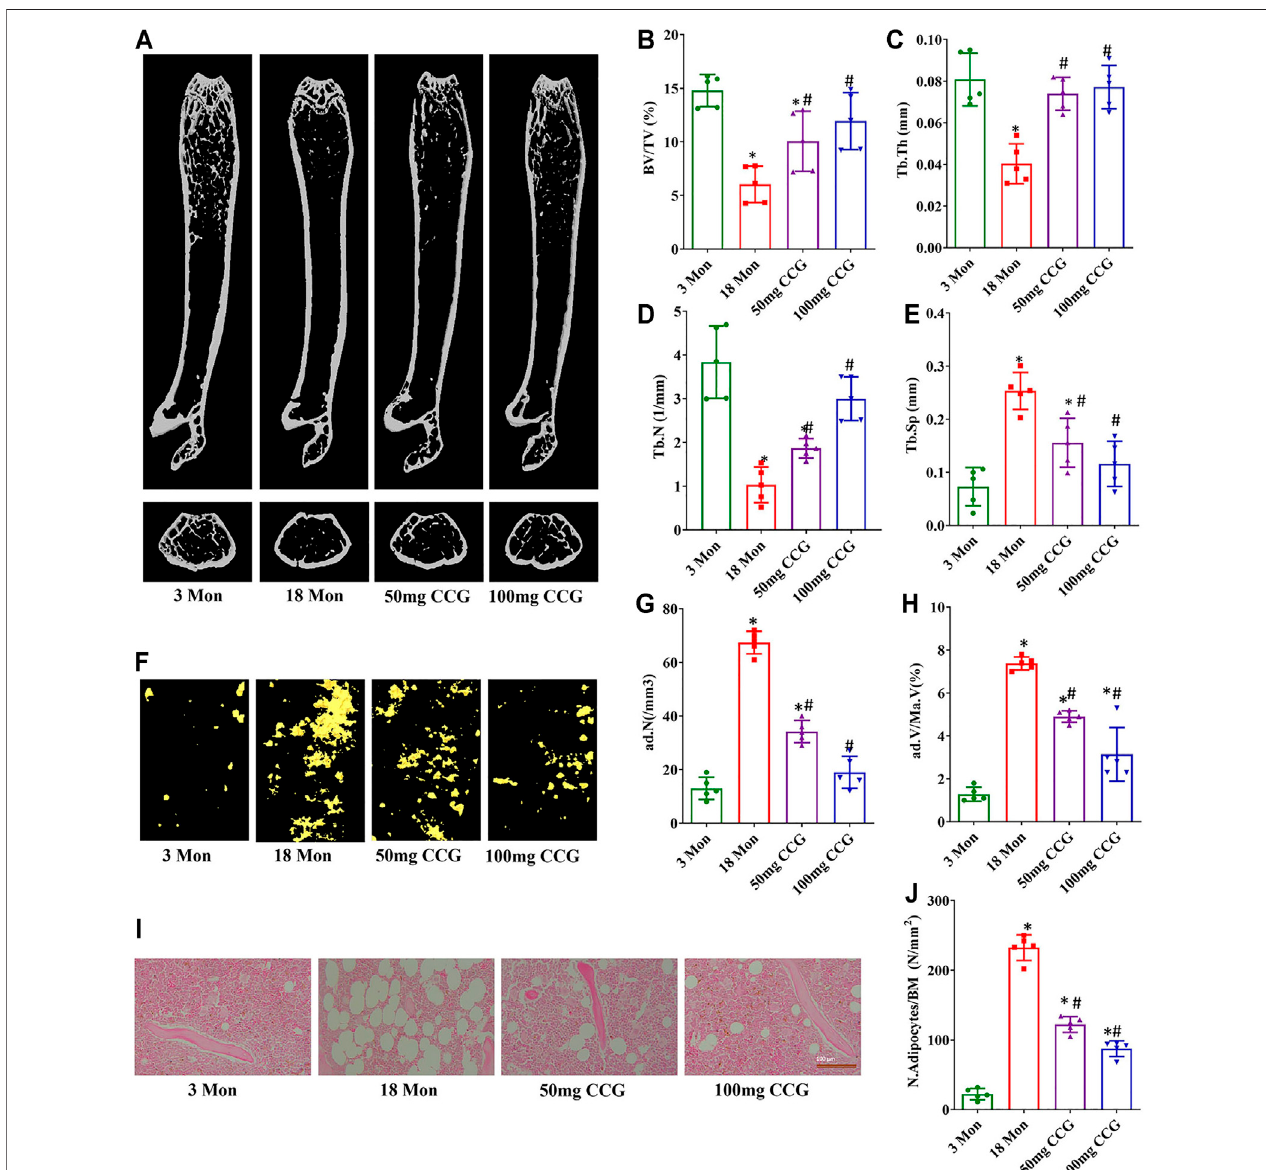
FIGURE 1 | CCG ameliorated bone loss and marrow adiposity of aging mice. (A – E) Representative μ -CT images of femurs from the animals in different groups to acquire the quantitative analysis of trabecular bone. (F – H) Representative μ -CT images of OsO 4 staining of femurs from the animals in different groups to acquire the quantitative analysis of the volume of adipocytes. (I, J) Representative images of H&E staining to show the ratio of adipocyte number to the area of bone marrow. Scale bar: 100 μ m (n (cid:1) 5) * p < 0.05 vs. the 3-mon mice group; # p < 0.05 vs. the 18-mon mice group.